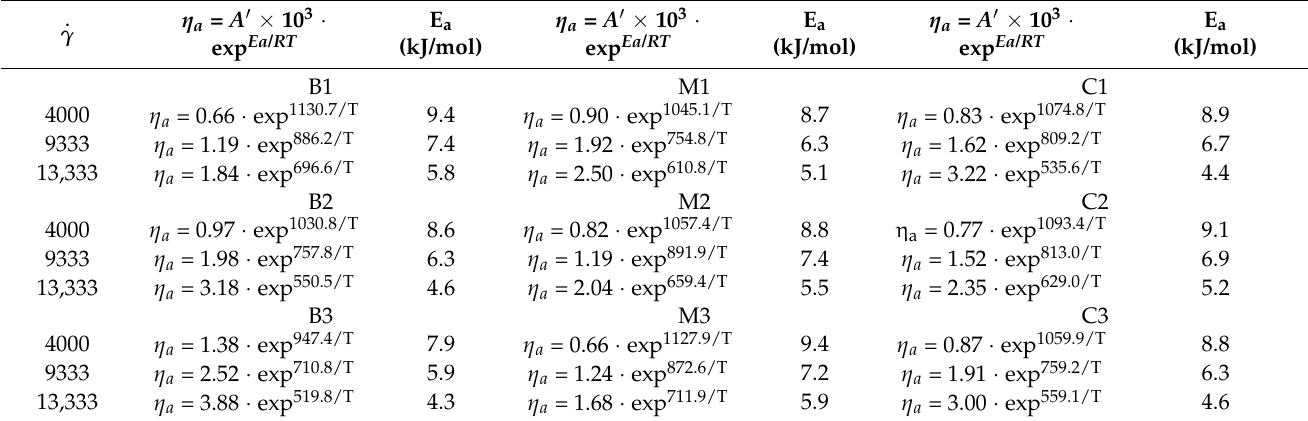
Table 6. Particular types of the Arrhenius equation for all